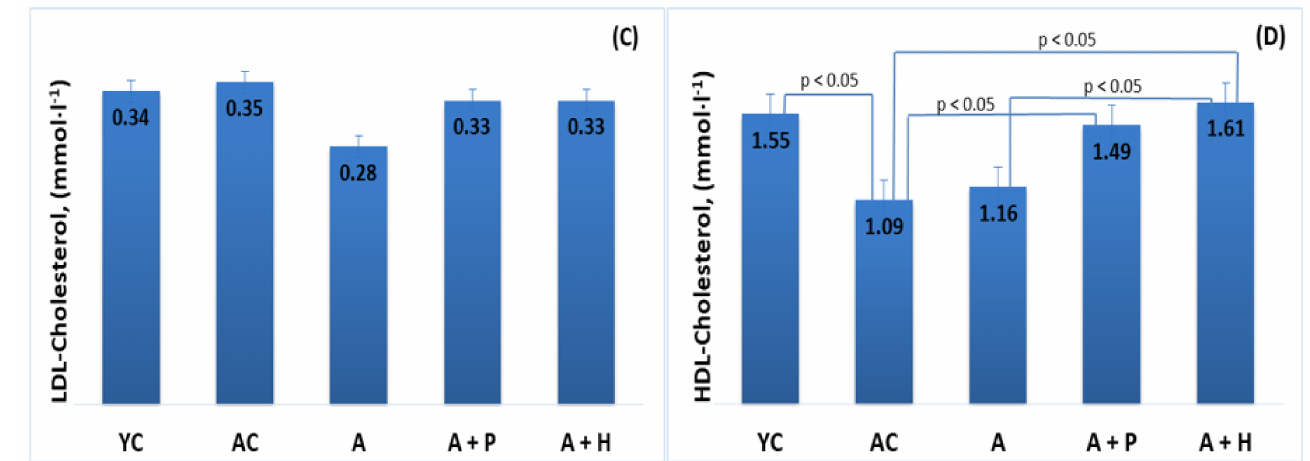
Figure 3. Serum ( A ) total cholesterol, ( B ) triglycerides, ( C ) LDL-cholesterol and ( D ) HDL-cholesterol of the animals from the experimental groups. The results are presented as mean values ± SEM.